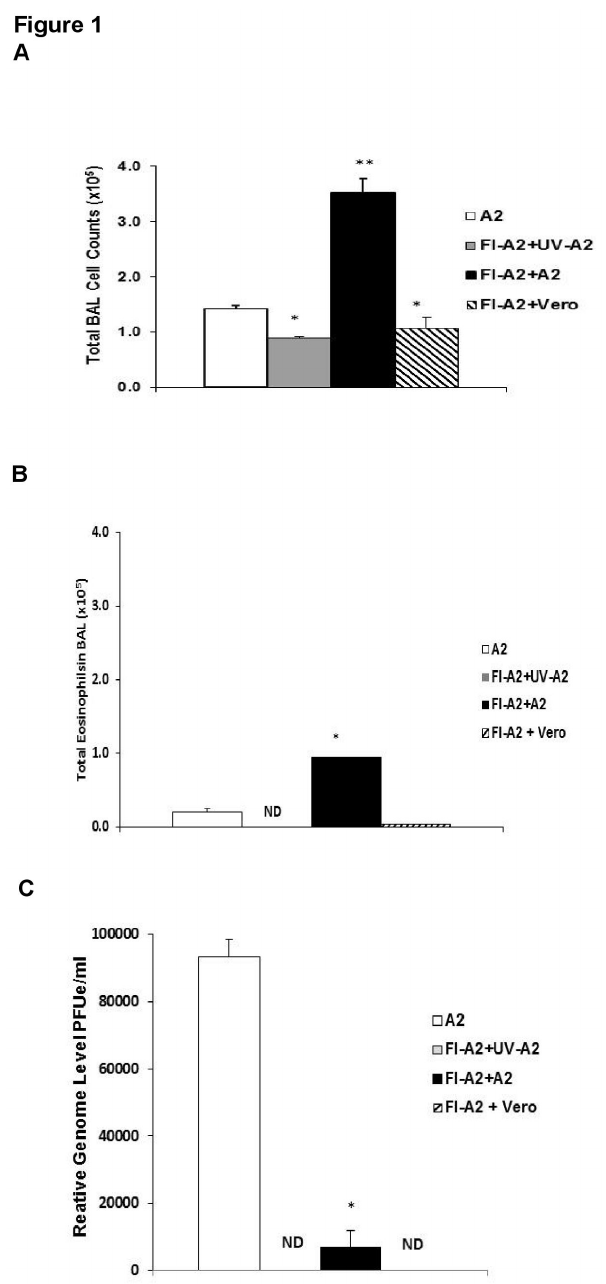
Figure 1. Vaccine enhanced disease in FI-A2 vaccinated mice after RSV Challenge. Mice were i.m. vaccinated with formalin inactivated RSV A2, rested for at four weeks and i.n challenged with either live RSV A2 (FI-A2+A2), UV-inactivated RSV A2 (FI- A2+UV-A2) or unifected vero cell lysate (FI-A2+vero). Unimmunized mice challenged with live RSV A2 (A2) provide a comparison to results after acute infection. Unvaccinated RSV challenged mice are compared to FI-RSV vaccinated mice challenged with live RSV mice and to FI-RSV vaccinated mice challenged with UV-inactivated RSV A2. Data from a separate experiment compares the inflammatory responses to FI-RSV vaccinated and vero cell lysate challenged mice. On day 5 post-infection, total BAL cell counts (A), total eosinophil counts (B) and viral RSV M gene mRNA (C) in the lungs of mice were determined. Total eosinophil counts were calculated by multiplying the total BAL cell counts by the percent eosinophils and presented as total eosinophils in BAL. Significance was calculated using a Student's t test, comparing mice in each group to mice vaccinated with FI-A2 alone and then challenged with RSV . * p <0.05 A2 compared to FI-A2+UV-A2 or FI-A2+vero; ** p <0.05 significance FI-A2 + A2 compared to either A2 or FI-A2+UV- A2 or FI-A2+vero. ND= not detected. doi: 10.1371/journal.pone.0083075.g001 PLOS ONE |